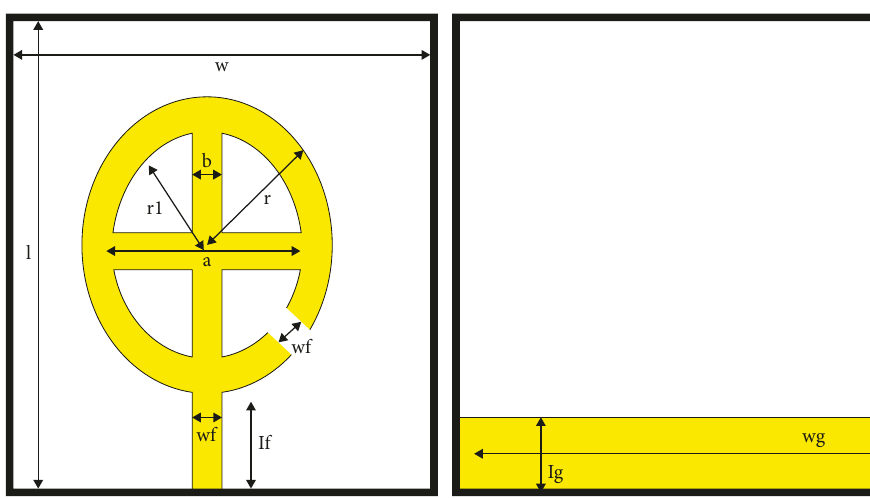
Figure 2: Pentaband cross stub circular monopole antenna.